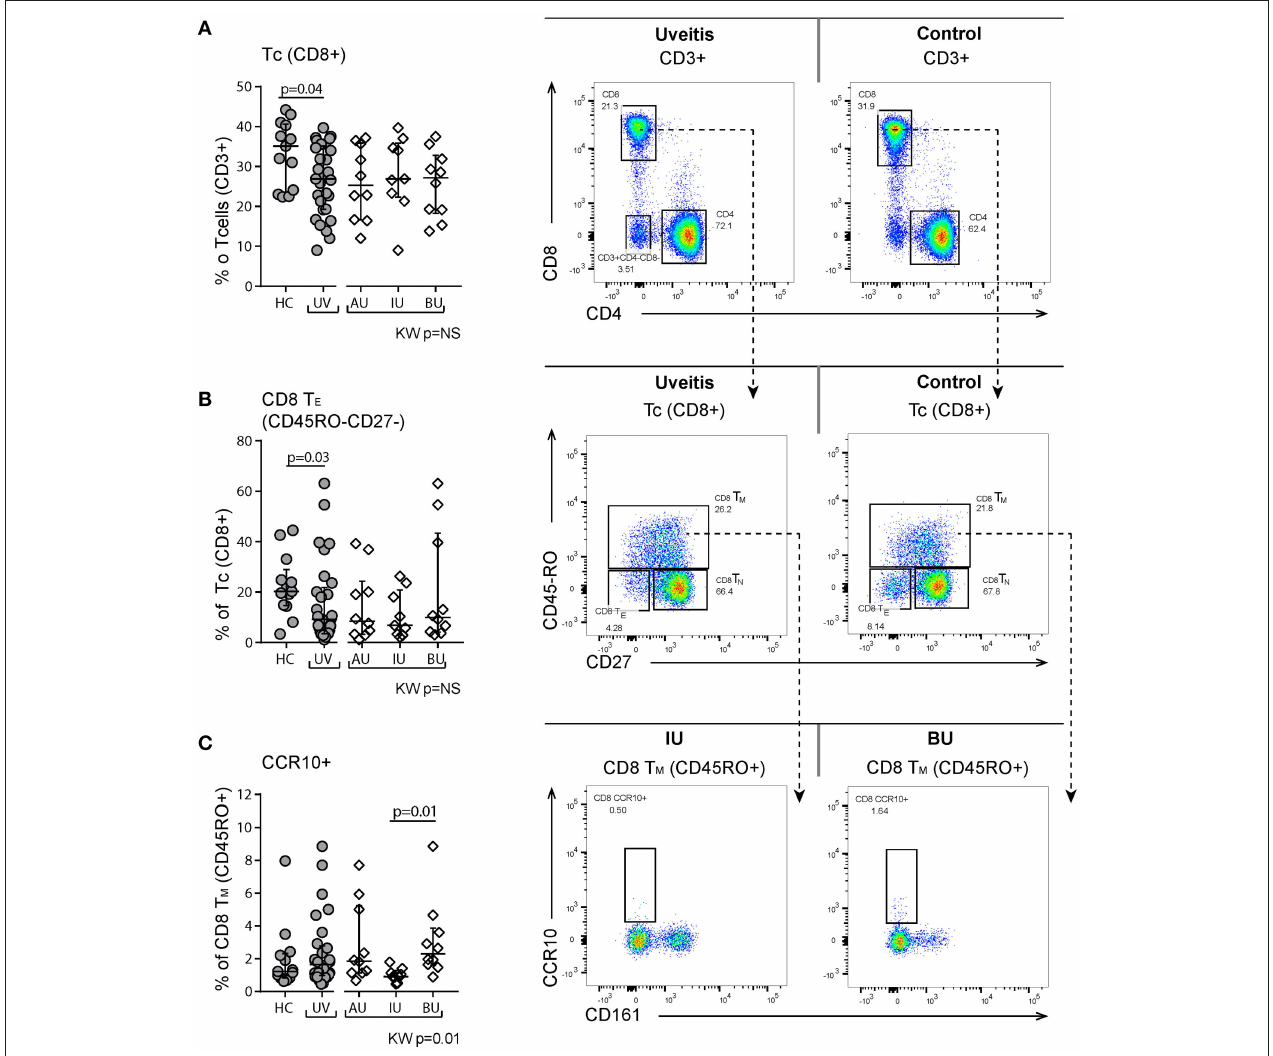
FIGURE 4 | Flow cytometry of peripheral blood mononuclear cells shows changes in the proportion of CD8 + T cell subsets. (A) Decrease of CD8 + T cells in uveitis compared to healthy controls. Representative patient and control sample. CD3 + cells are gated from live single cells, as is indicated in Figure S1 . (B) Decrease in the CD45RO-CD27- T E population. (C) CCR10 + CD8 + T M cells are significantly higher in BU compared to IU. Bars in plots indicate median, error bars indicate interquartile range. P -values between HC and UV are from Wilcoxon rank-sum test, p -values between uveitis subgroups are from Kruskal–Wallis (KW) test with post-hoc Dunn’s correction for multiple testing. AU, HLA-B27 associated anterior uveitis; BU, Birdshot uveitis; HC, healthy control; IU, idiopathic intermediate uveitis; Tc, cytotoxic Tcell; Th, Thelper cell; T E , effector Tcells (CD45RO-CD27-); T N , naïve (CD45RO-CD27 + ); T M , memory (CD45RO + ); UV, Combined Uveitis